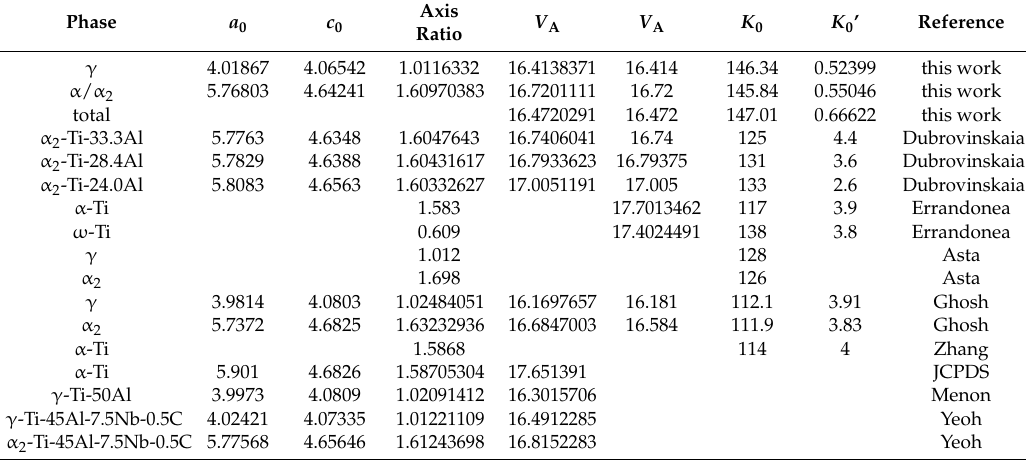
Table 1. Compilation of experimental lattice parameters a 0 and c 0 under ambient conditions, as well as the derived quantities; their axis ratios and volume per atom V A , compression parameters K 0 , K 0 ’ (first 3 rows) and data from the literature. The α -phase lattice is given in α 2 cell notation, and therefore, 2 c / a is noted. The first V A column is computed from a 0 and c 0 , while the second results from the fit of pressure data to Equation (6). The original data of Yeoh’s publication [31] has been re-visited to extract the listed values at 300 K. Literature values are reported from their experimental findings, in addition to Ghosh’s first-principles study [61]. Further listed references are Dubrovinskaia [59], Errandonea